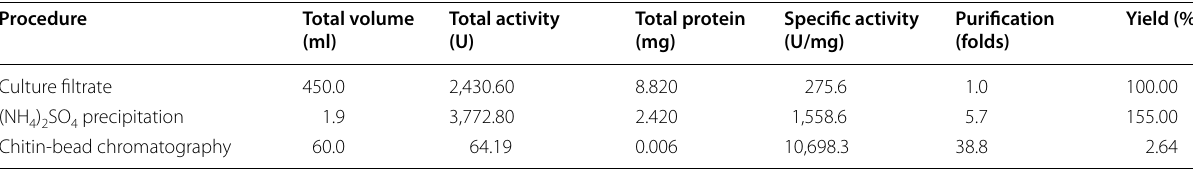
Table 1 Purification of NAGase from T. virens . T. virens strain mango were cultured in a liquid medium containing chitin for 8 days, followed by the purification steps, including ammonium sulfate precipitation, and a chitin‑bead affinity chromatography, followed by NAGase activity assay using p NP‑NAG as substrate